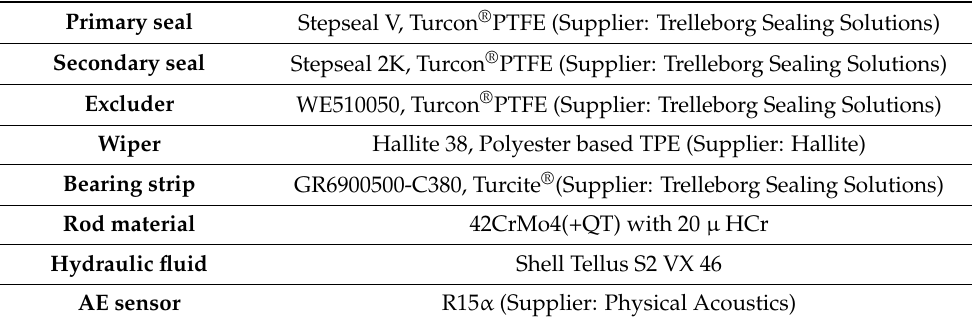
Table 1. Test rig details.